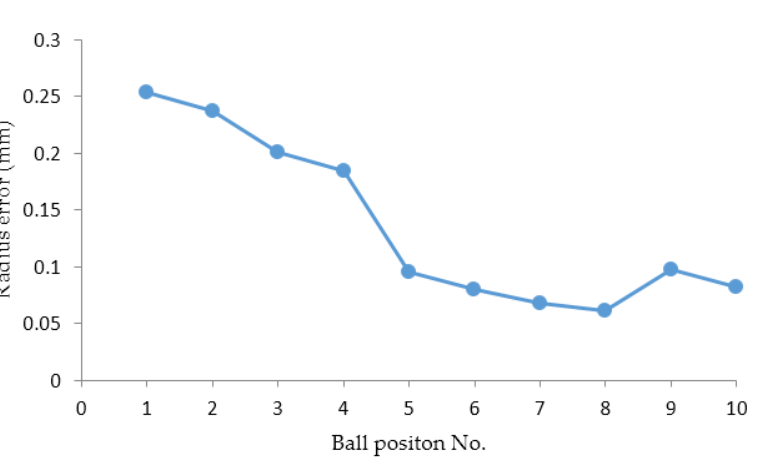
Figure 8. The errors between the fitted radii and the standard radius.